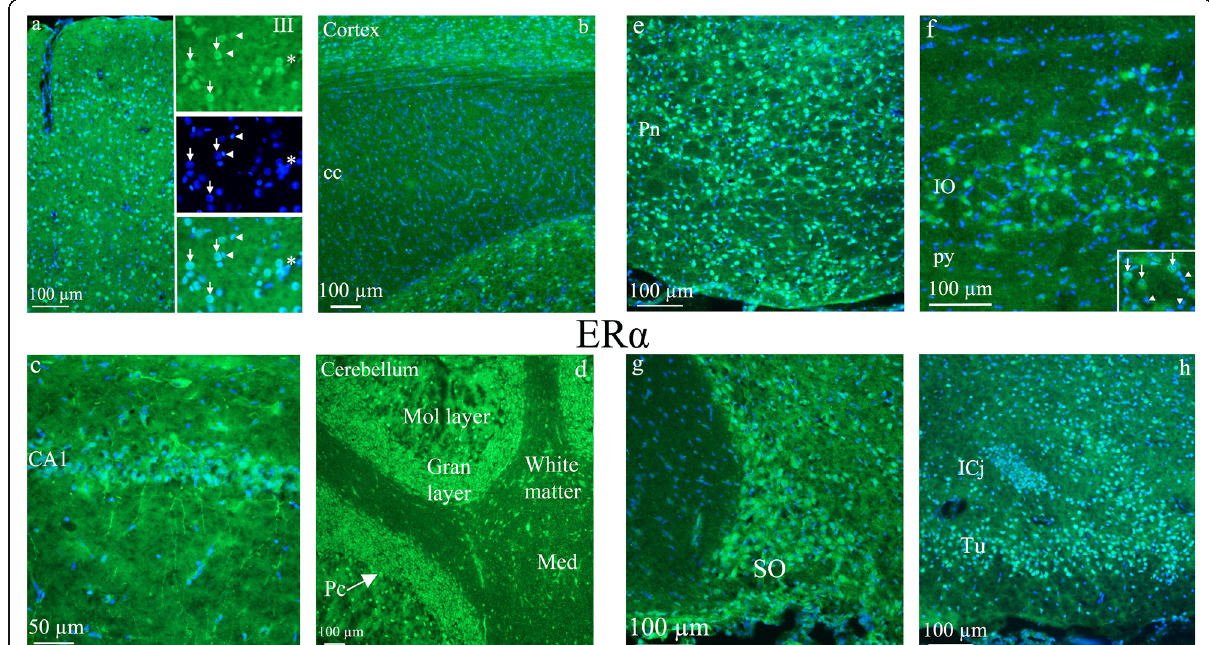
Fig. 2 ER α receptor distribution. a Cerebral occipital cortex - all layers of the cortex contained ER α immunoreactivity, except for the outer molecular layer (layer I). In the column in the middle, from the top ER α immunohistochemistry is visualized in layer III, in the middle DAPI nuclear staining and at the bottom the merged images. Arrows point at nuclei of ER α positive neurons, arrowheads at negative glial cells and asterisk at a blood vessel. b In the white matter corpus callosum (cc), very few or no ER α expressing nuclei were found. c ER α receptor distribution in